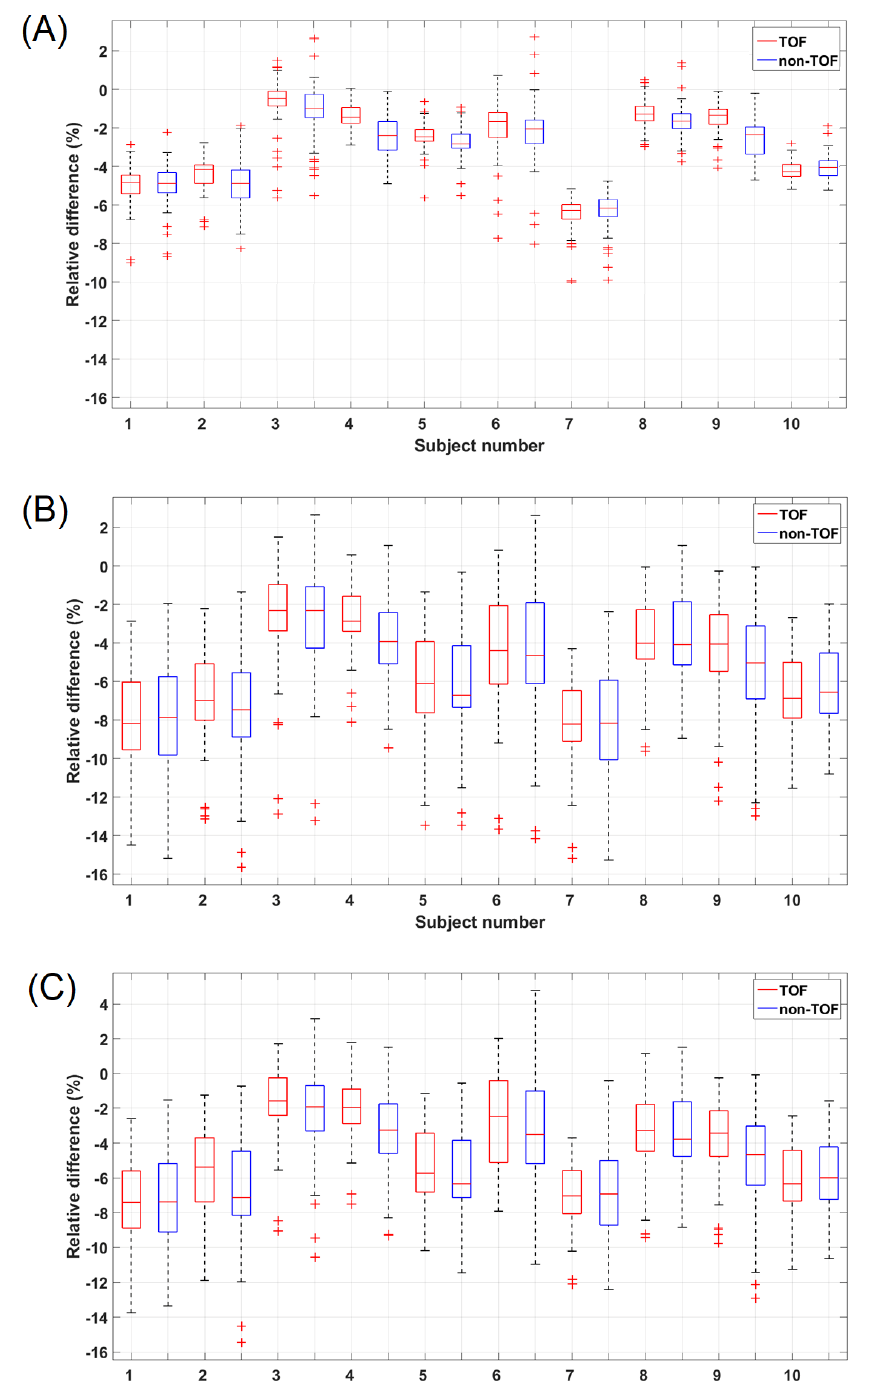
Figure 2. Box and whisker plots of the relative difference to CTAC reconstructed PET when using TOF and non−TOF reconstructed images. ( A ) 3−class MRAC, ( B ) 2−class MRAC, ( C ) 2−class MRAC without air cavities. The box plots show the results of each patient using the set of 35 VOIs’ mean bias as data. For each subject, the red TOF box plot is presented first, followed by blue non-TOF box plot immediately to its right. Outlier values are denoted with red ‘+’ symbol. A value beyond the maximum whisker length of 1.5 times the quartile range is considered an outlier.